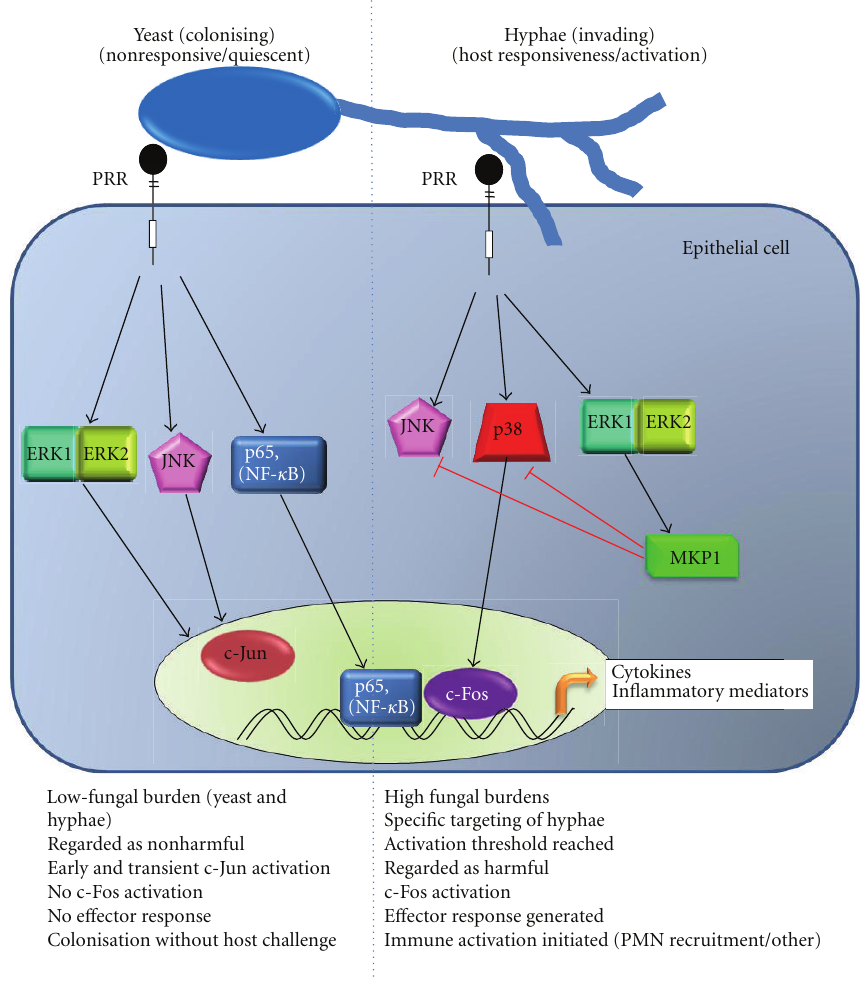
Figure 2: Epithelial cell recognition of C. albicans . Epithelial cells recognise C. albicans via a two-step process [40]. Initial recognition of yeast by surface PRRs results in prolonged activation of NF-kB and an early transient activation of MAPK signalling leading to activation of c-Jun through the ERK1/2 and JNK pathways. When the burden of hyphae passes a threshold, recognition of these hyphae triggers a second, prolonged activation of MAPK signalling. This results in activation of MKP1 through the ERK1/2 pathway and c-Fos via p38 signalling. NF- κ B and c-Fos then play essential roles in the transcription of cytokines secreted by the epithelial cells, whilst MKP1 acts as a negative regulator to control the activation of JNK and p38